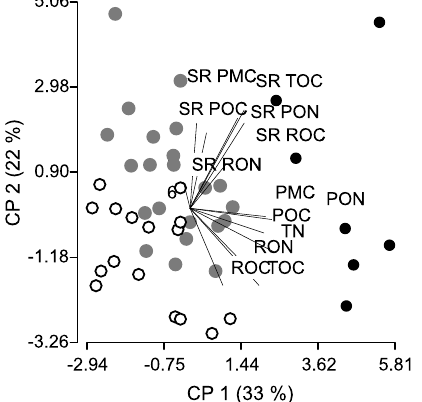
Figure 5. Biplot of principal component analysis. Vectors indicate the relative weight of each variable on the axes: total organic carbon (TOC) and nitrogen (TN), particulate organic carbon (POC) and nitrogen (PON), potential minera- lizable carbon (PMC), resistant organic carbon (ROC) and nitrogen (RON), and their stratification ratios (SR) 0–5/5–15 cm. Shaded circles: no-tillage soil (NT), empty circles: conventionally tilled soil (CT); and black circles: undisturbed soil